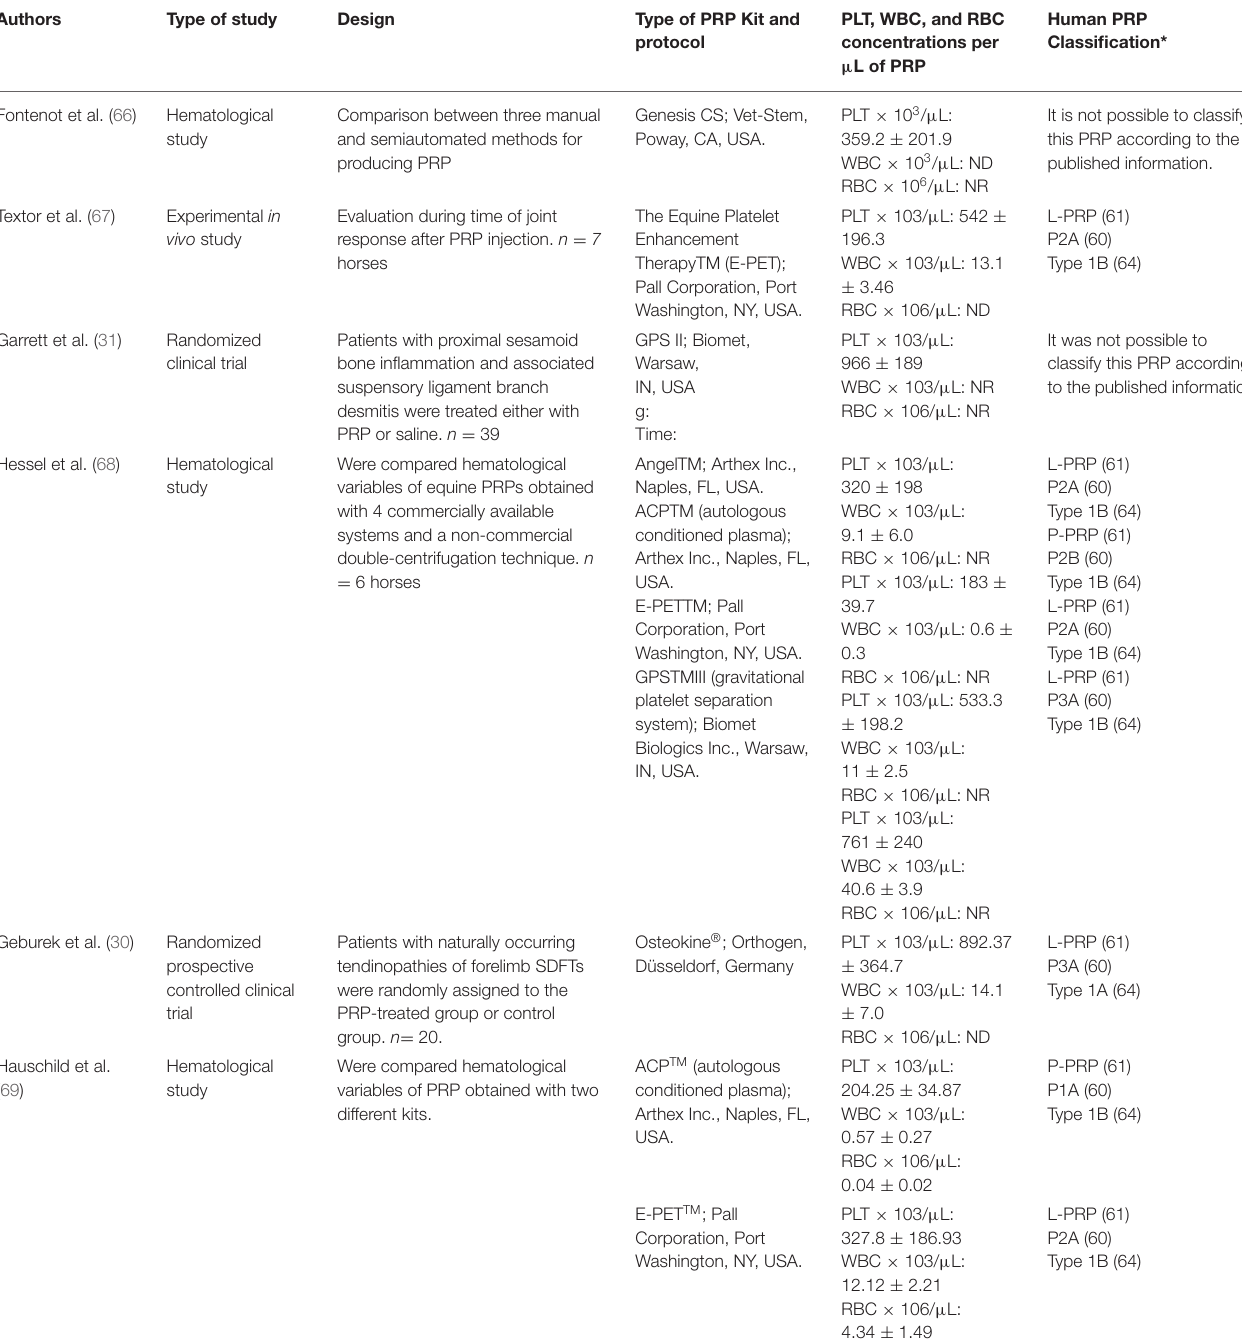
TABLE 2 | Semiautomated methods used for PRP production from equine blood and potential classification according to the systems proposed for human PRP